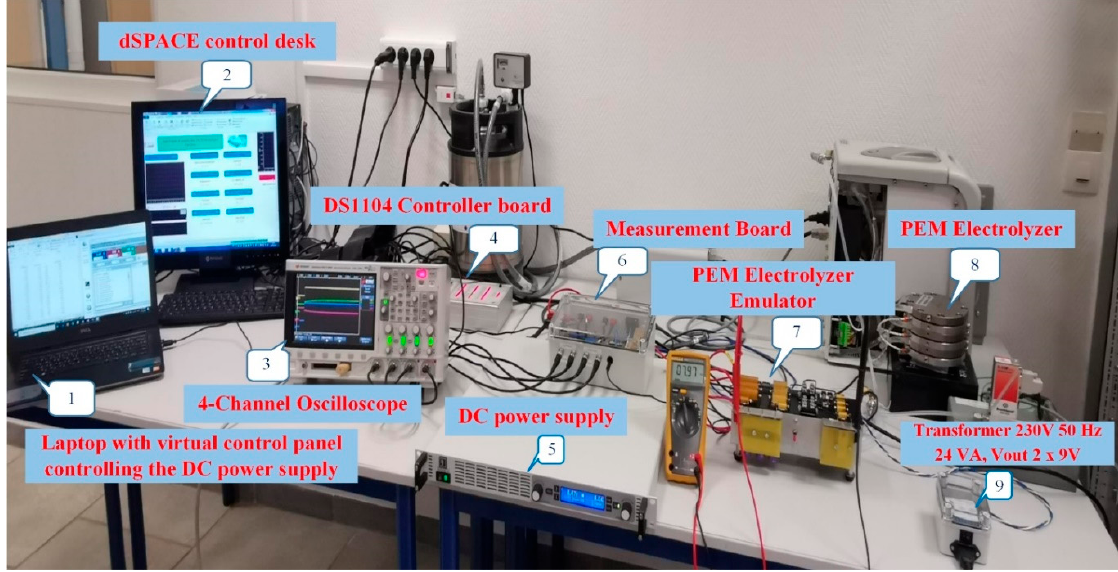
Figure 9. Realized experimental test bench to validate the PEM electrolyzer emulator.